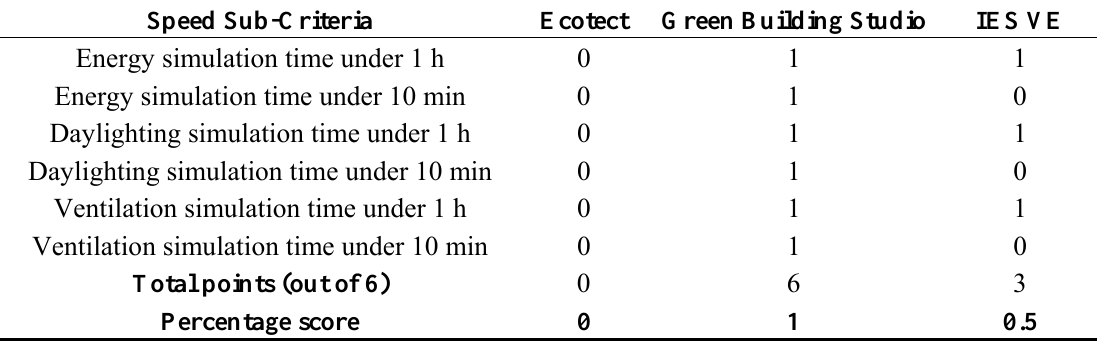
Table A11. Re-evaluation: speed criterion calculations for the top three BEM tools.